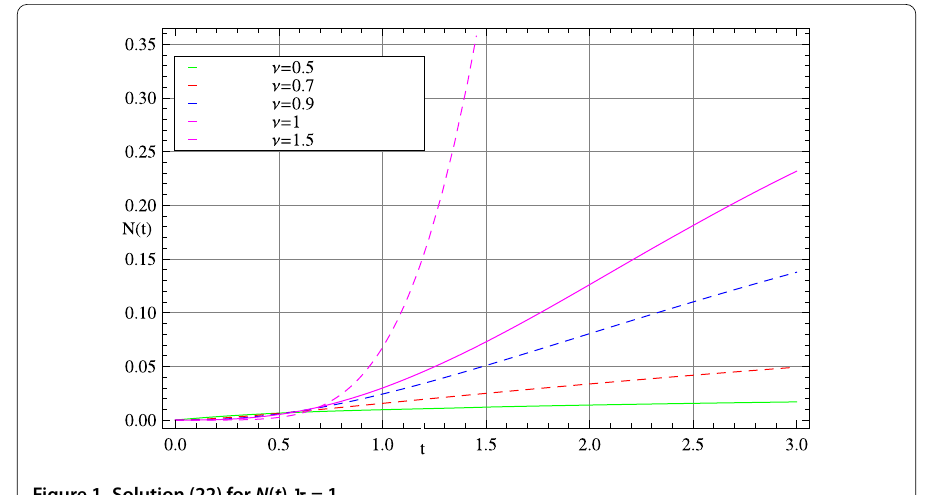
Figure 1 Solution (22) for N ( t ), k = 1.